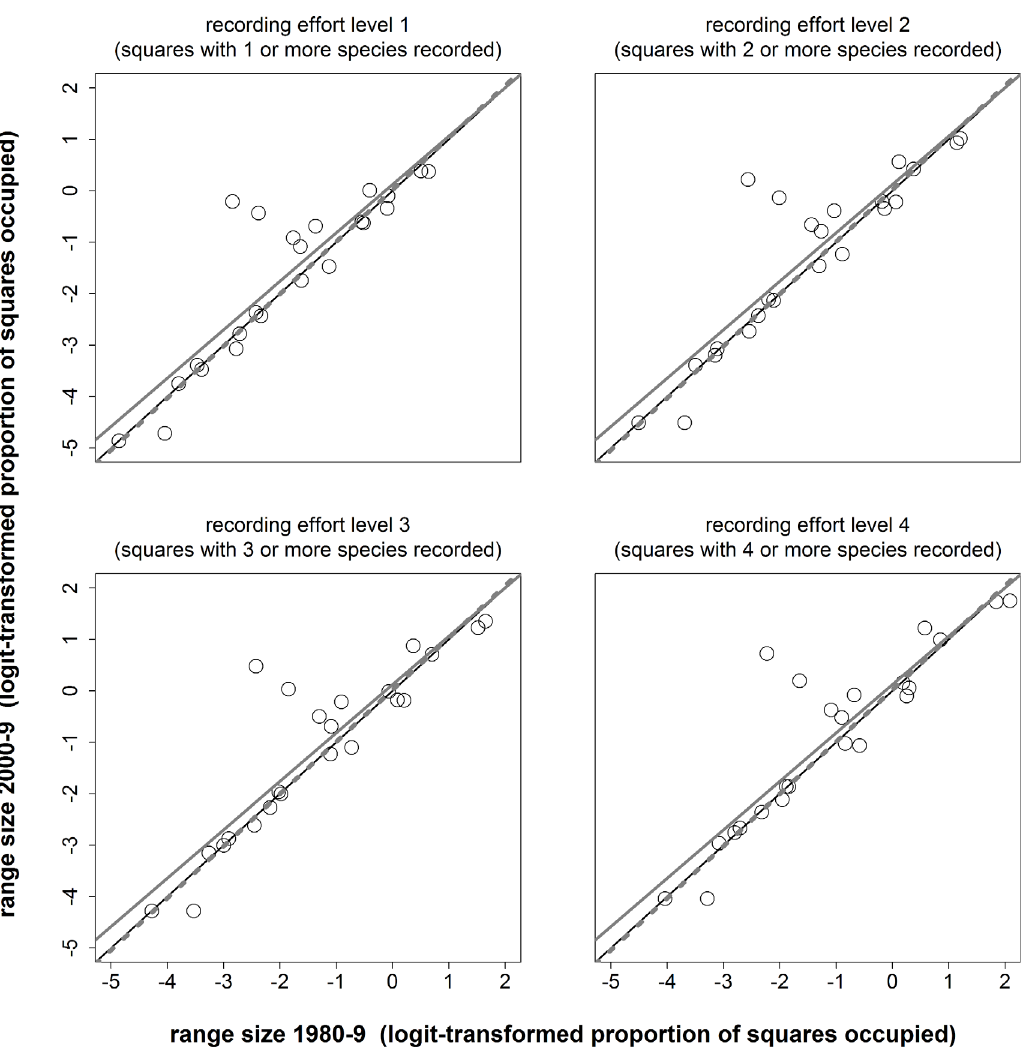
Fig 3. Grasshopper and related species range sizes in 1980 – 9 and 2000 – 9 and calculation of range change measures. The figure plots range sizes in 1980 – 9 vs. 2000 – 9 (as logit-transformed proportions of squares occupied) for four levels of recording effort. “ Uncorrected range change ” was defined as the absolute change in range size, i.e. residual distances from the (black) 1:1 unity lines. “ Corrected range change ” was defined as change in range size relative to the mean change across species, i.e. as the (standardised) residual distances from the linear regression lines (solid grey for all species, dashed grey for species excluding the two with particularly large range change values, C . discolor and M . roeselii